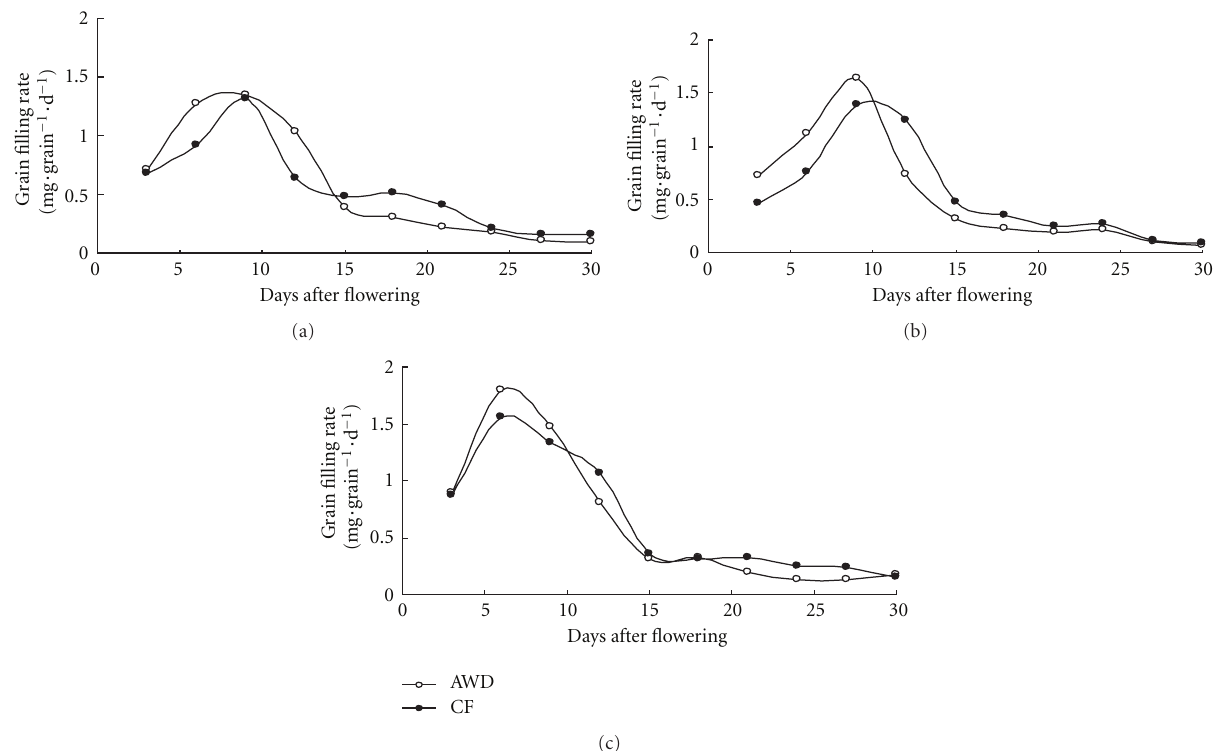
Figure 5: Grain filling rate after flowering under AWD and CF in 2010 DS. Three varieties IR72 (a), IR82372H (b), and SL-8H (c) were used in the experiment at high N